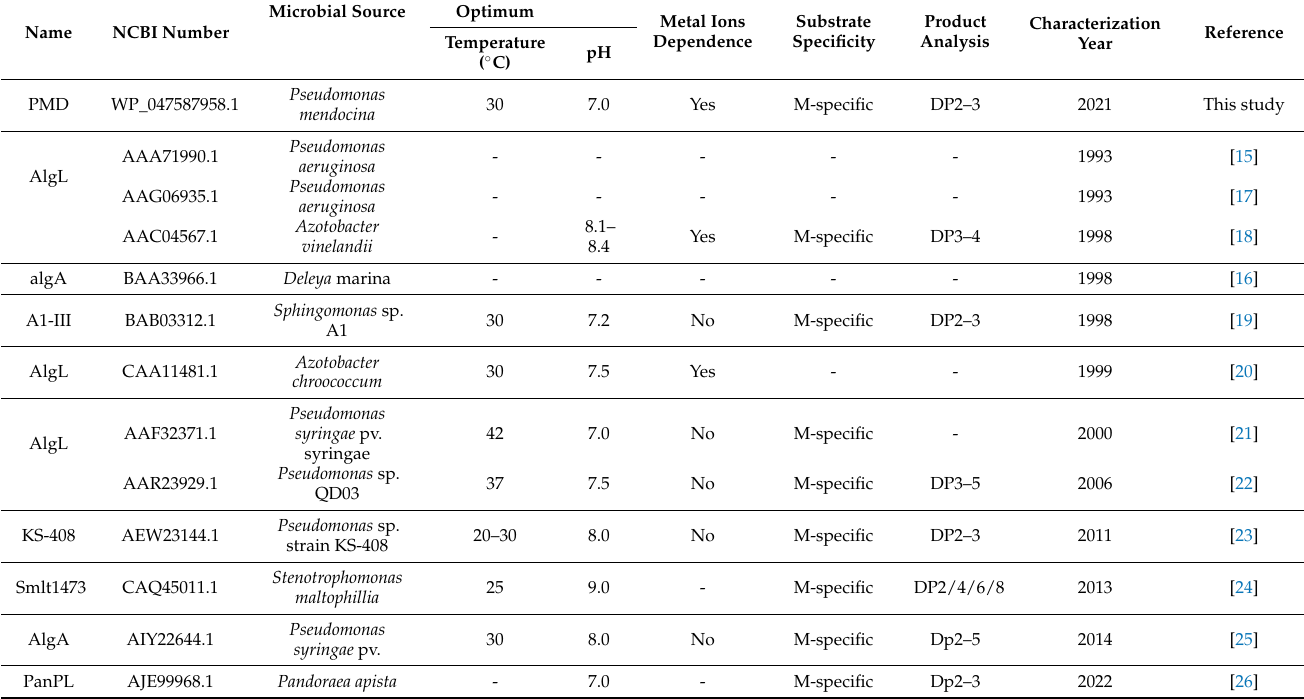
Table 1. Data of all characterized PL5 family alginate lyases so